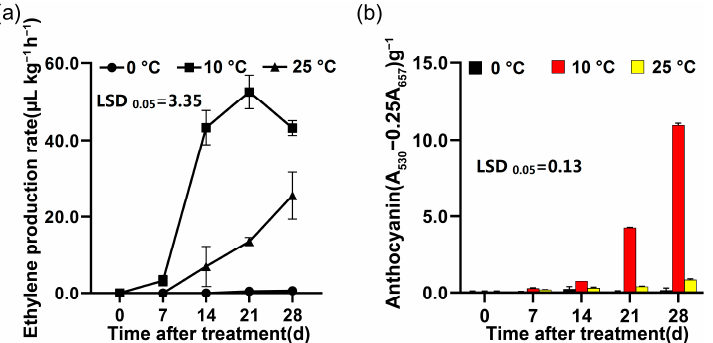
Figure 1. Changes of ethylene production rate ( a ) and anthocyanin content in flesh ( b ) of ‘Friar’ plum fruit under different storage temperatures. The vertical bar represents the standard error while the LSD values show significant differences at the 0.05 level.